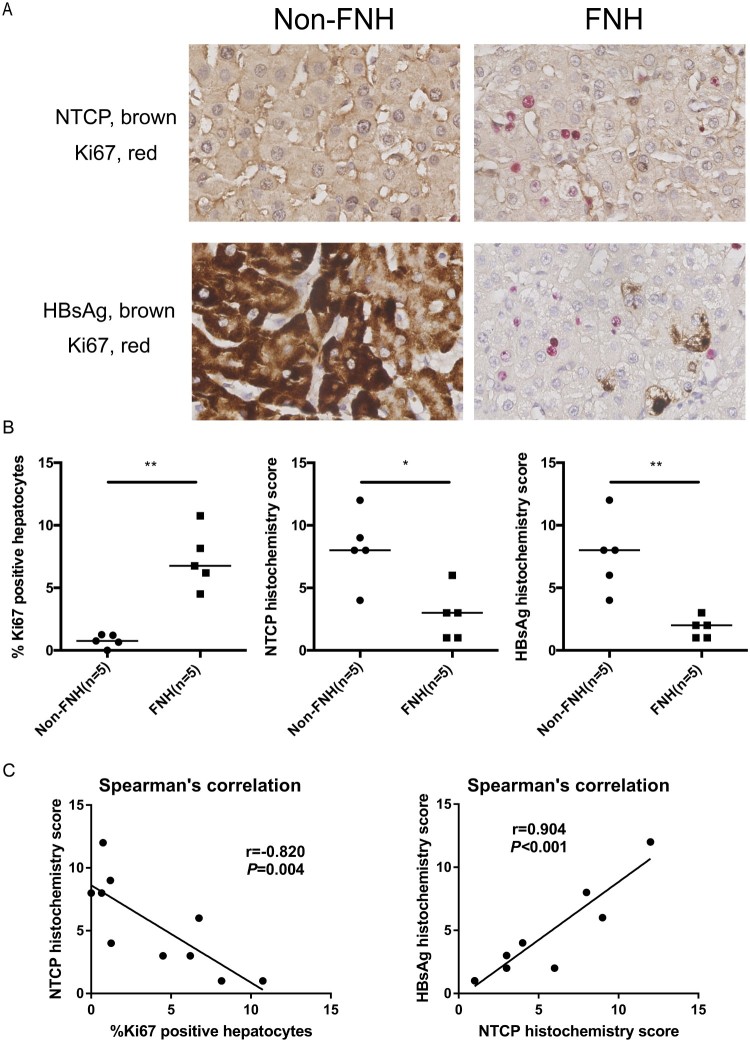
FNH tissues contain more Ki67-positive hepatocytes, along with significantly lower NTCP and HBsAg expression. (A) Immunohistochemical double staining of Ki67, NTCP and HBsAg in FNH tissues and adjacent non-FNH tissues. The top row showed the double staining of NTCP (brown) and Ki67 (red), and the bottom row showed the double staining of HBsAg (brown) and Ki67 (red). (B) The percentage of Ki67-positive hepatocytes (calculated by the average of five counted fields in every tissue) and the histochemistry scores of NTCP and HBsAg (calculated by positive hepatocyte ratio multiplied with the staining intensity). (C) Spearman's correlation of NTCP histochemistry scores and the percentage of Ki67-positive hepatocytes, the histochemistry scores of NTCP and HBsAg (*P < 0.05; **P < 0.01; ***P < 0.001).